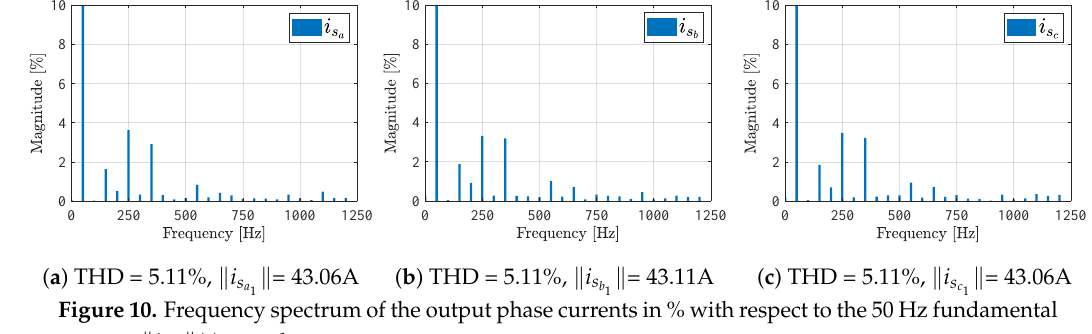
Figure 10. Frequency spectrum of the output phase currents in % with respect to the 50 Hz fundamental i s current, y = a, b, c. y 1 (cid:107) ∀ (cid:107)